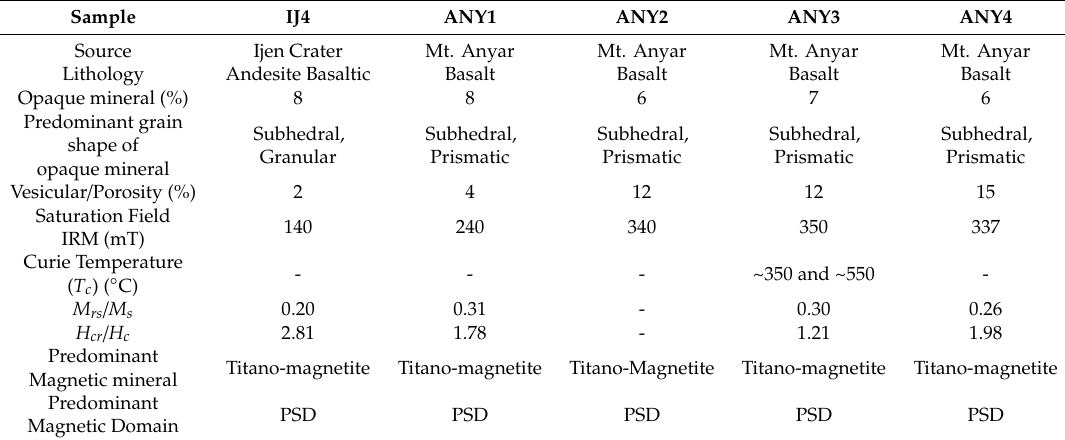
Figure 1. The Ijen Volcanic Complex map shows the distribution of volcanic products and eruption centers. Red dots indicate the sampling sites (modified from reference [25]). Table 1. Magnetic and petrography data of the samples